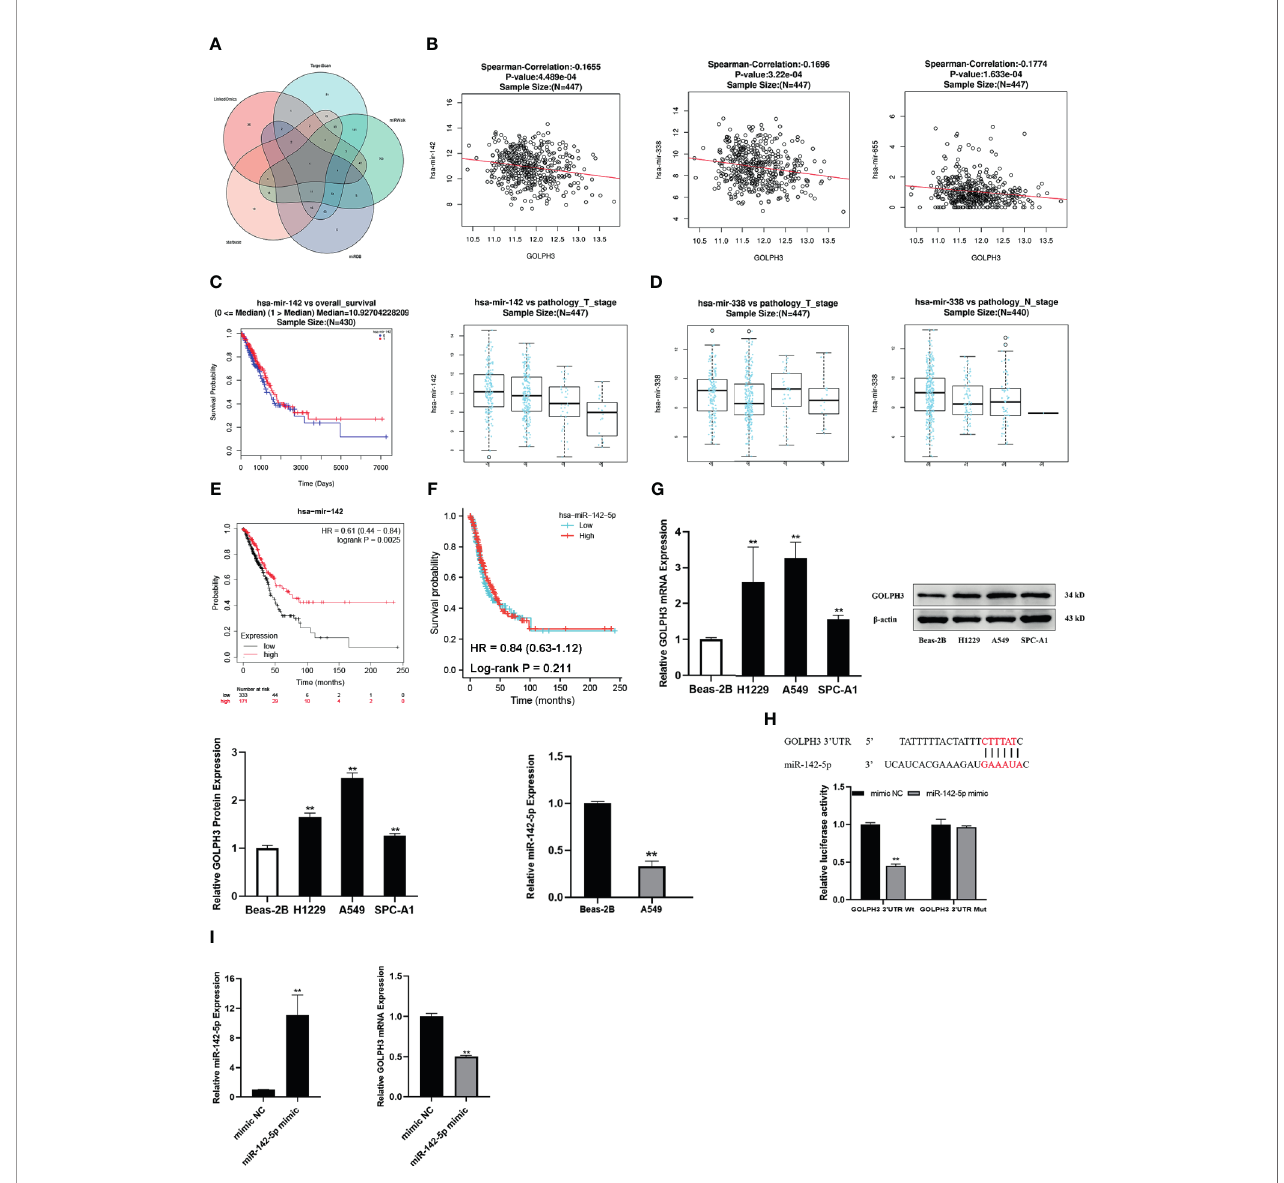
FIGURE 8 | Construction of miRNA – GOLPH3 network. (A) Candidate miRNAs (miR-142-5p, miR-183-5p, miR-338-5p, and miR-655-3p) are predicted by LinkedOmics, TargetScan, miRWalk, miRDB, and starBase. (B) The expression relationship between miRNAs and GOLPH3. (C) The clinical relevance of miR-142 with LUAD in LinkedOmics. (D) The clinical relevance of miR-338 with LUAD in LinkedOmics. (E) The overall survival (OS) of miR-142 in LUAD by Kaplan – Meier plotter. (F) The fi rst progression (FP) of miR-142-5p in LUAD using TCGA database. (G) The expression of miR-142-5p and GOLPH3 in Beas-2B and LUAD cells using qRT-PCR and Western blotting. (H) The luciferase reporter assay of A549 cells was transfected with the GOLPH3-3 ′ -UTR-Wt or GOLPH3-3 ′ -UTR-Mut in the miR-142-5p binding sites. (I) The expression of miR-142-5p and GOLPH3 in A549 cells with overexpression of miR-142-5p using qRT-PCR. ** p < 0.01. LUAD, lung adenocarcinoma; TCGA, The Cancer Genome Atlas.